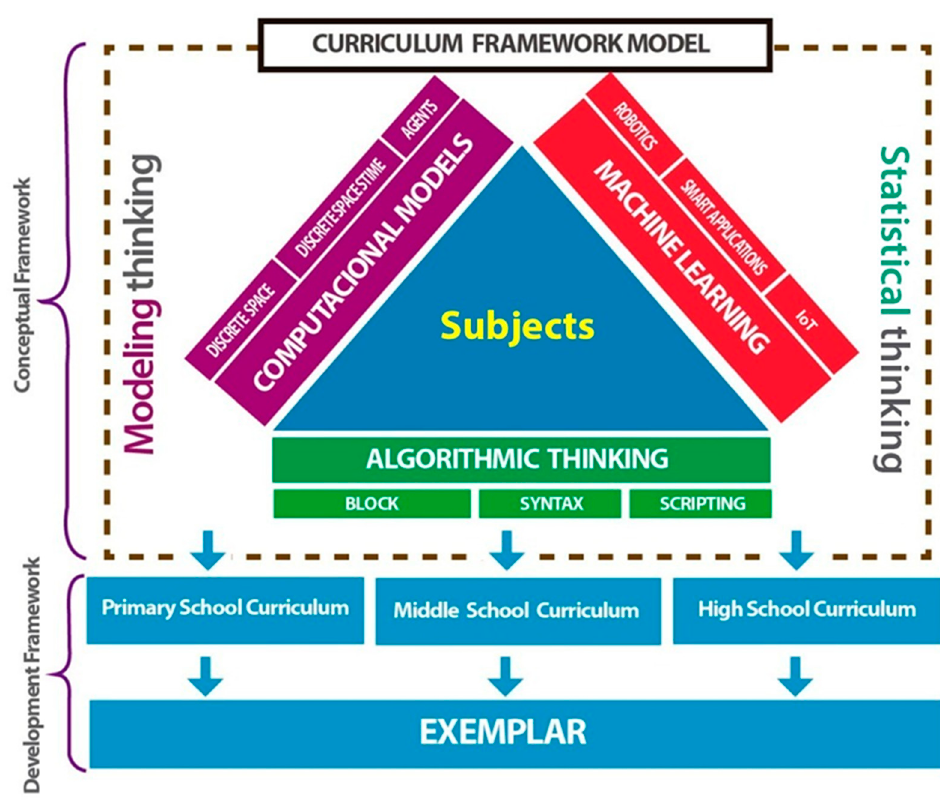
Figure 1. Curriculum framework model.